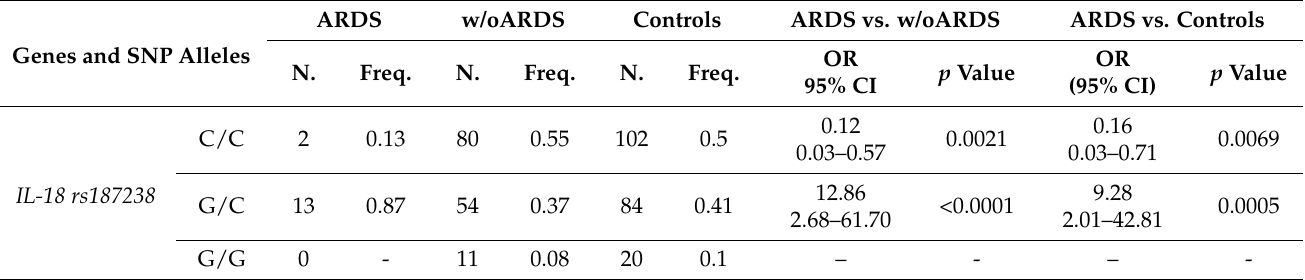
Table 6. Association of IL-18 rs187238 genotypes with Acute Respiratory Distress Syndrome (ARDS) in 15 patients affected by Mediterranean Spotted Fever (MSF) compared to MSF without ARDS (w/oARDS) and Healthy Controls (adjusted by 64 years Age cut off and Sex).